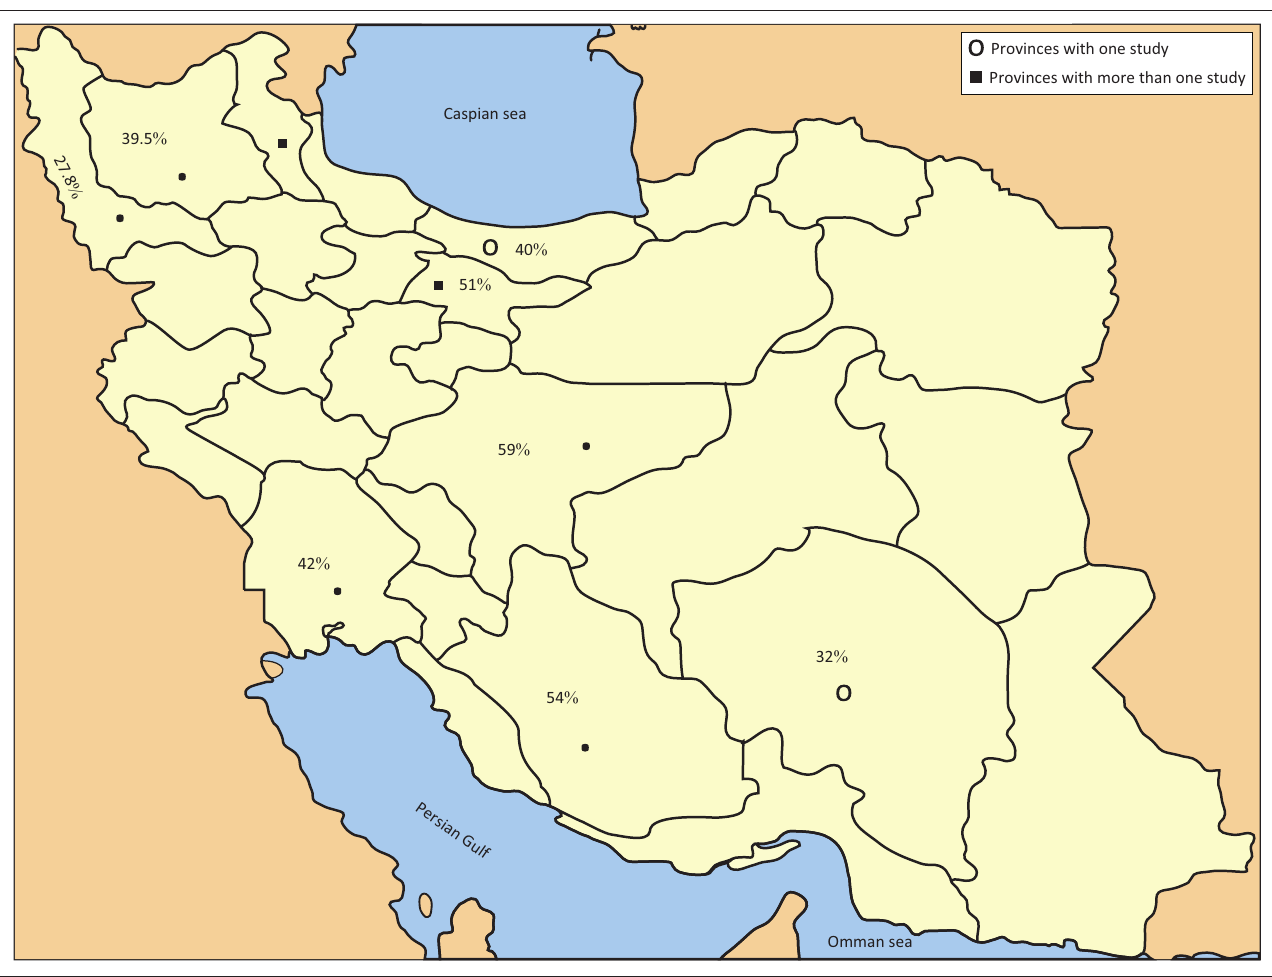
FIGURE 3: Prevalence of toxoplasmosis in cats in different